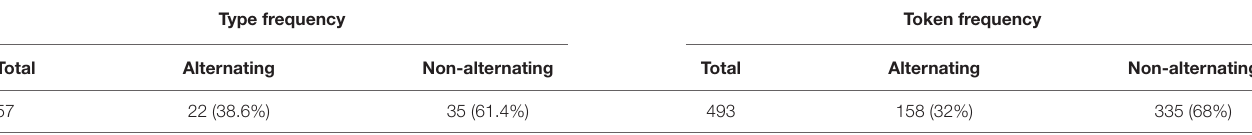
TABLE 1 | Type and token frequency counts of alternations in singular–plural pairs.